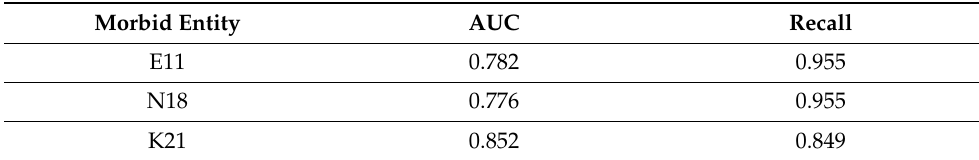
Figure 12. E11 logistic regression. Table 3. Model Performance.